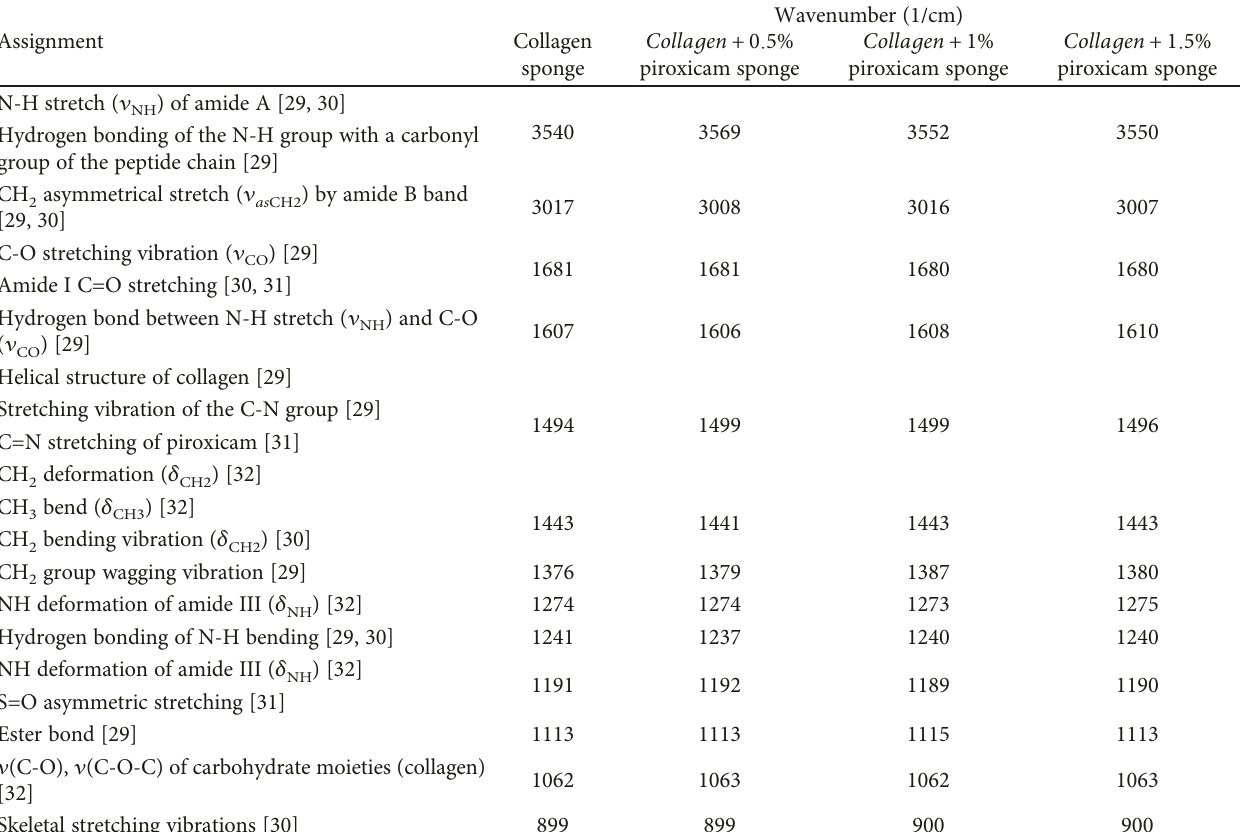
Table 1: FTIR spectra peak position and assignments for collagen sponges.